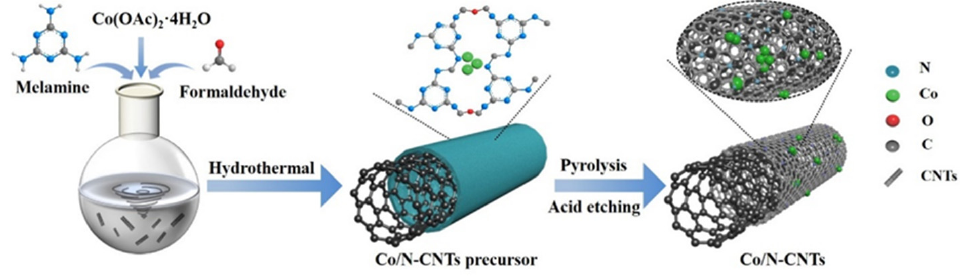
Figure 10. The preparation procedure of Co/N-CNTs catalysts. Reprinted with permission from Ref.